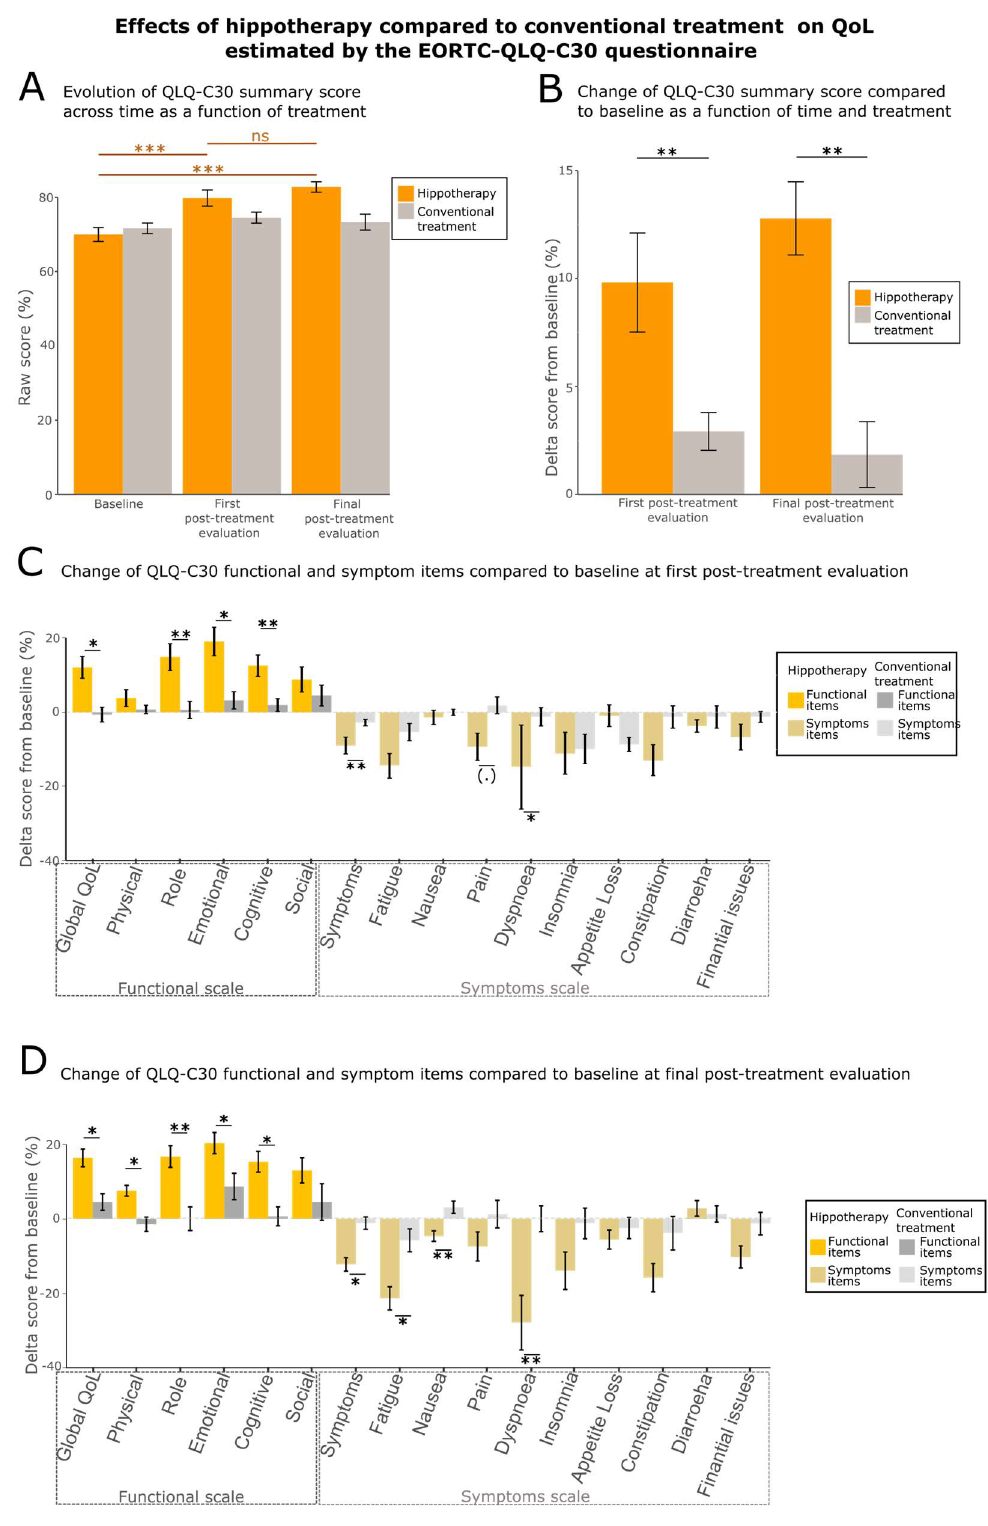
Figure 2. Effects of hippotherapy treatment compared to conventional treatment on QoL, estimated by the EORTC-QLQ-C30 questionnaire. ( A ) Bar chart represents means (M) and standard errors of means (SEM) of the evolution of QLQ-C30 scores across time, as a function of treatment type. Values (M ± SD) are as follows: Baseline = 70.0 ± 15.0, First post-treatment evaluation = 79.8 ± 17.3, Final post-treatment evaluation = 82.80 ± 11.2 for the hippotherapy group; Baseline = 71.6 ± 11.3, First post-treatment evaluation = 74.5 ± 11.9, Final post-treatment evaluation = 73.3 ± 17.1 for the control group. ( B ) Change in score compared to baseline QLQ-C30 score (M ± SEM), as a function of time and